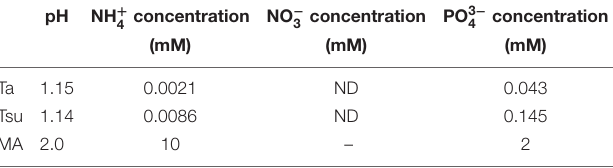
TABLE 1 | pH, inorganic nitrogen (NH + 4 and NO − 3 ) and phosphorus (PO 3 − 4 ) concentrations in the Ta and Tsu hot spring waters and synthetic MA